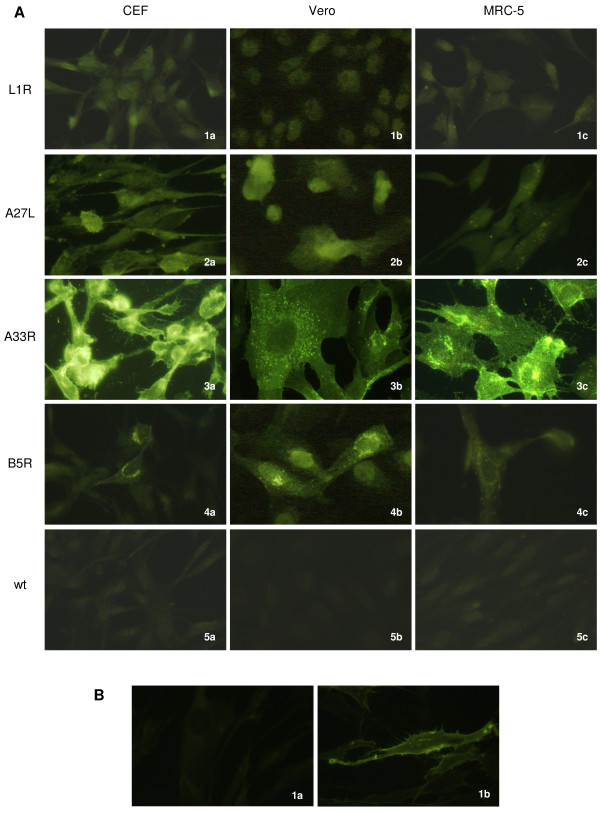
Heterologous protein localisation by immunofluorescence. (A) Intracellular immunofluorescence was detected in all of the cell lines, with differences between the proteins ascribed to MV or EV particles. In cells infected with FPL1R or FPA27L the cytoplasmic immunofluorescence was diffuse (panels 1a-c, 2a-c), and in FPL1R-infected cells, the difference with the negative control was very low. Conversely, specific, granular perinuclear localisation was shown by the cells infected with FPA33R or FPB5R (panels 3a-c, 4a-c), which was particularly evident in MRC-5 cells infected with FPA33R. FPwt-infected cells were negative (panels 5a-c). (B) MRC-5 cells showed membrane immunofluorescence only after infection with the FPA33R recombinant (panel 1bvs. 1a).